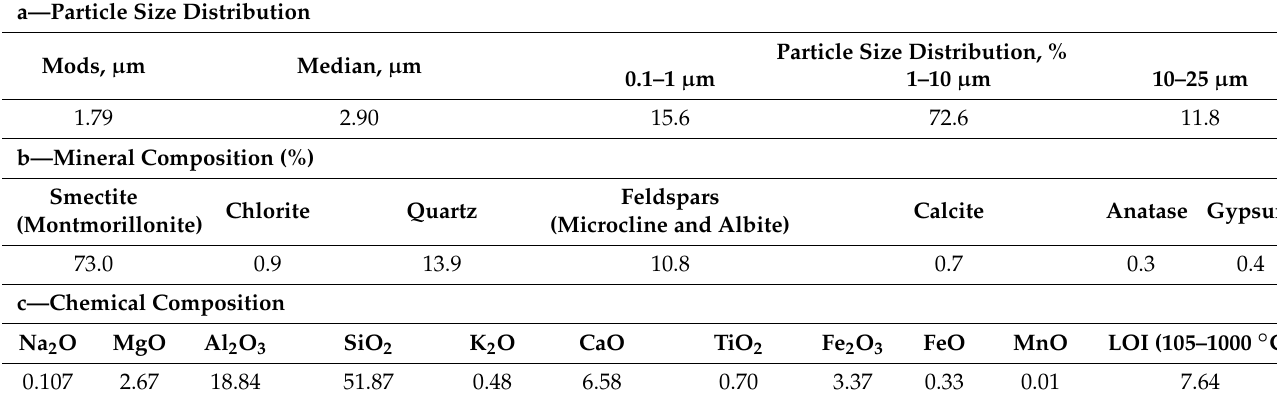
Table 1. Basic characteristics of bentonite powder